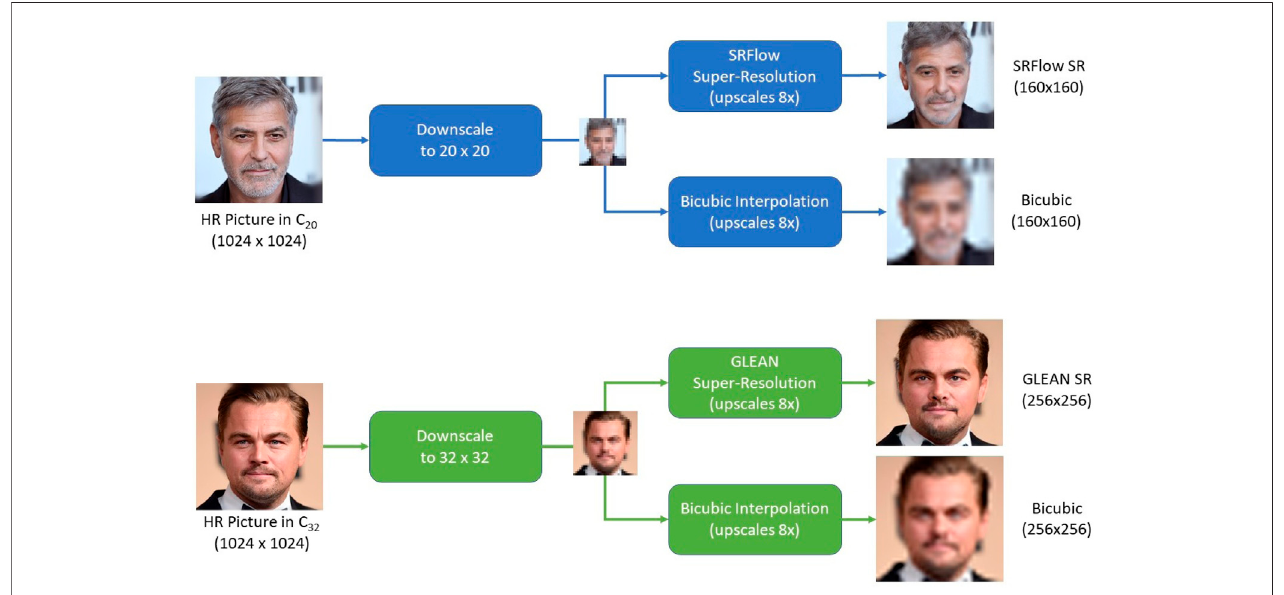
FIGURE 1 | Visual representation of the image generation approach used in our work.